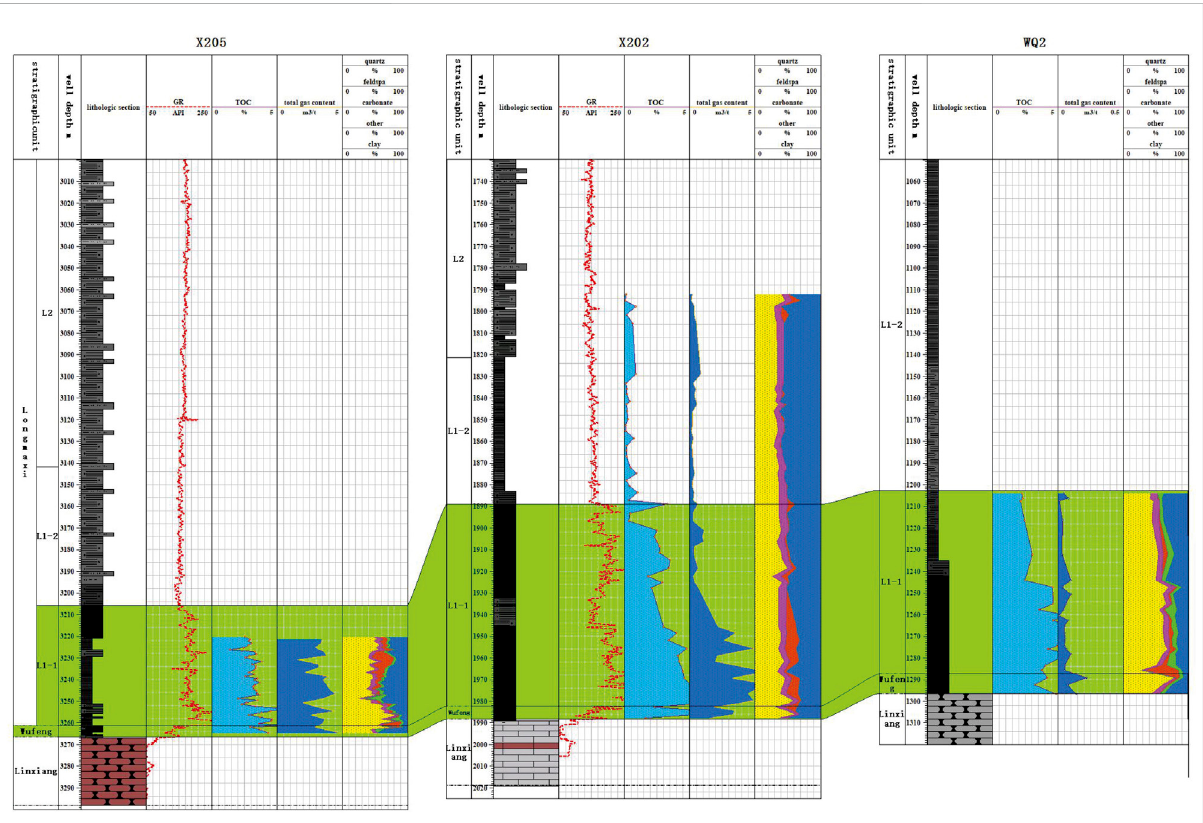
FIGURE 7 Connecting the well pro fi le of shale target layers in the Wufeng − Longmaxi